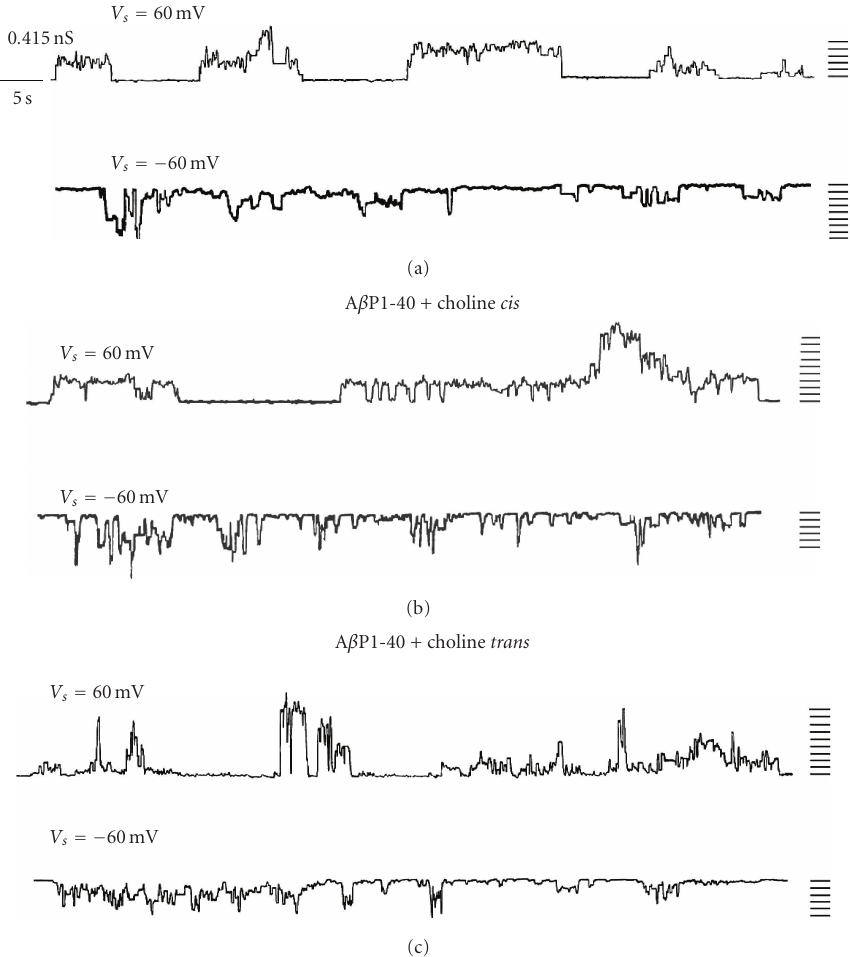
Figure 1: A β P1-40 channel activity in OxCh PLM in the absence and in the presence of choline. Representative A β P1-40 channel in the absence (a), in the presence of choline on the cis (b), or on the trans (c) side of the medium facing an OxCh PLM at an applied voltage of ± 60mV. Each trace represents a fragment of the recording of the activity obtained in individual experiments. Note the increased activity of the channel and the frequent multiple levels of conductance, especially at positive applied voltages, when choline is present. Experimental conditions KCl 50mM, A β P1-40 5 × 10 − 8 M were present to the cis side of the membrane, choline 5 × 10 − 11 M was added on the cis or trans side of the